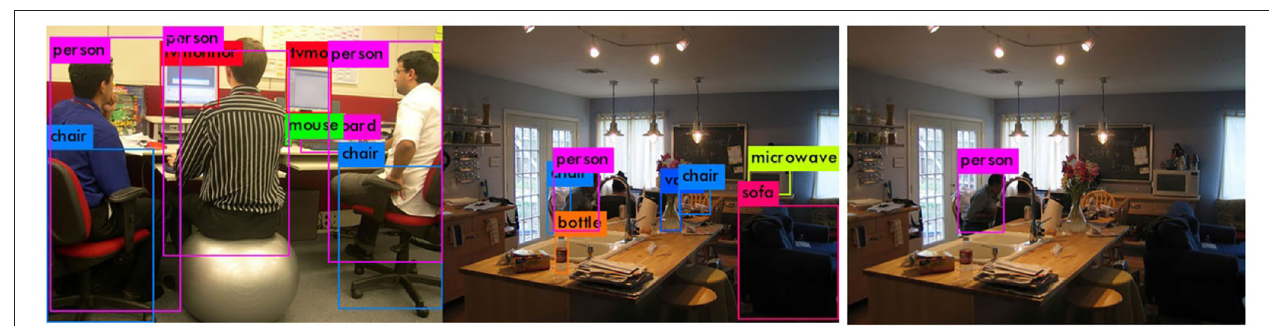
FIGURE 10 | The result of category detection. (A) Multi-category detection. (B) Single-category detection.